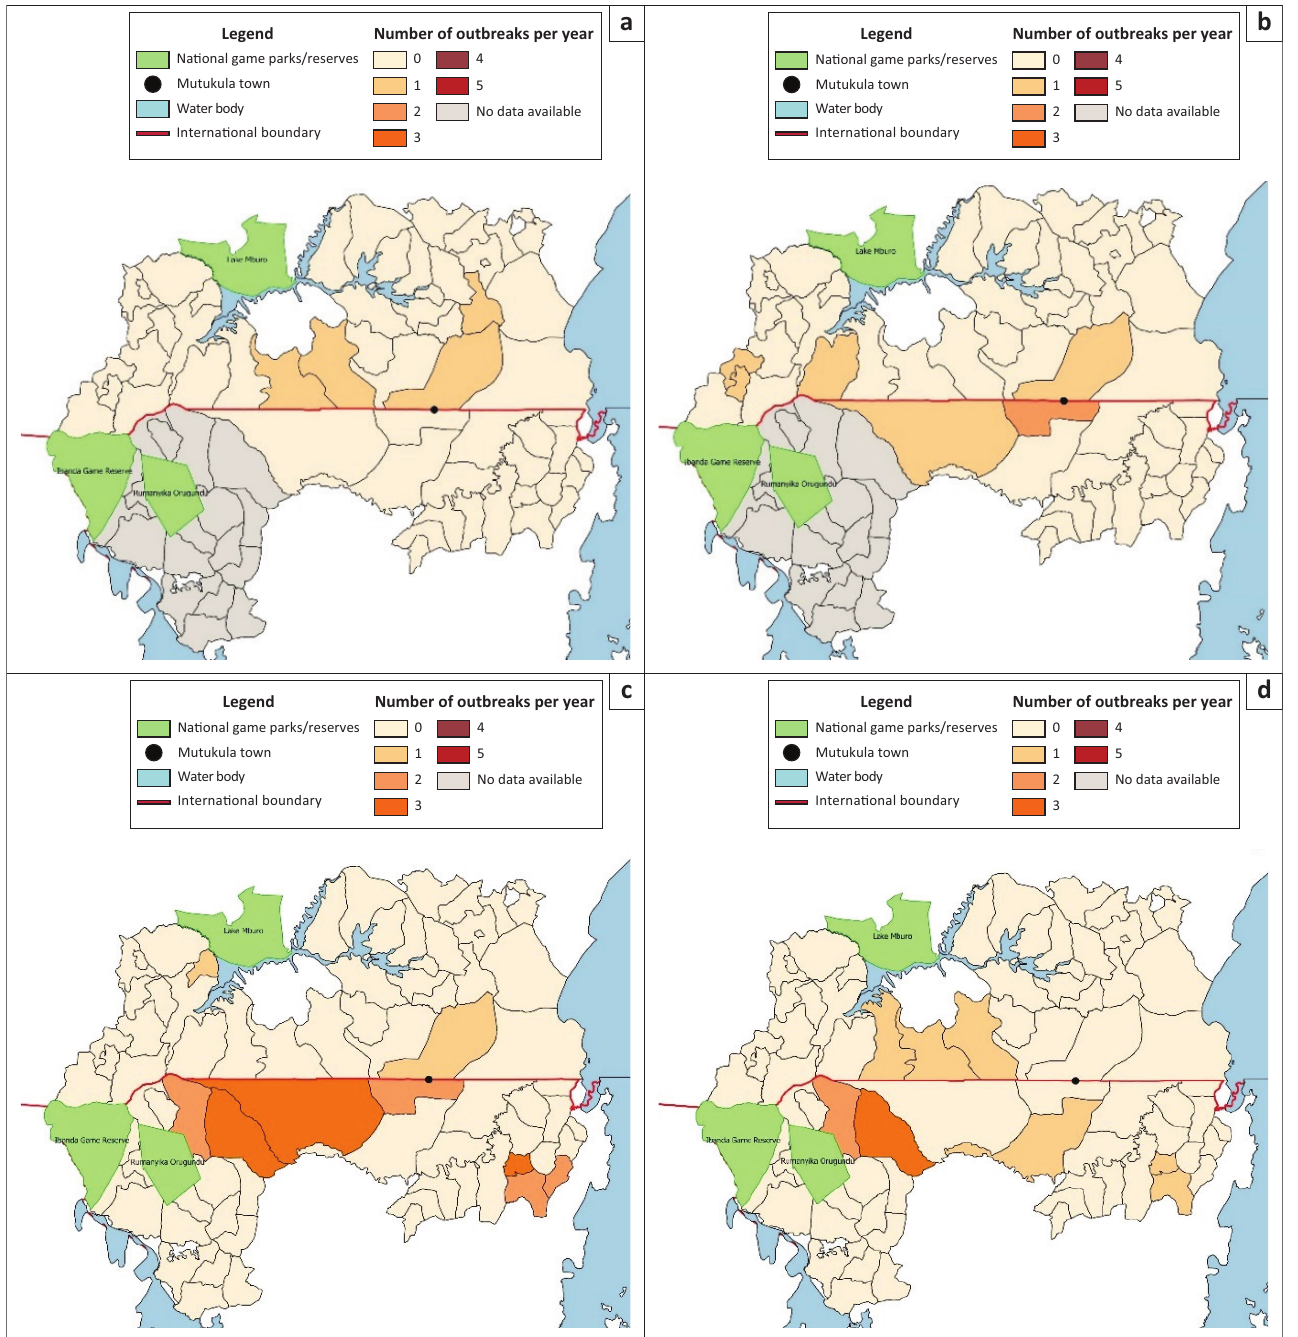
FIGURE 2: Spatial distribution of foot-and-mouth disease in sub-counties and/or wards in border districts of Uganda and Tanzania between 2011 and 2016.